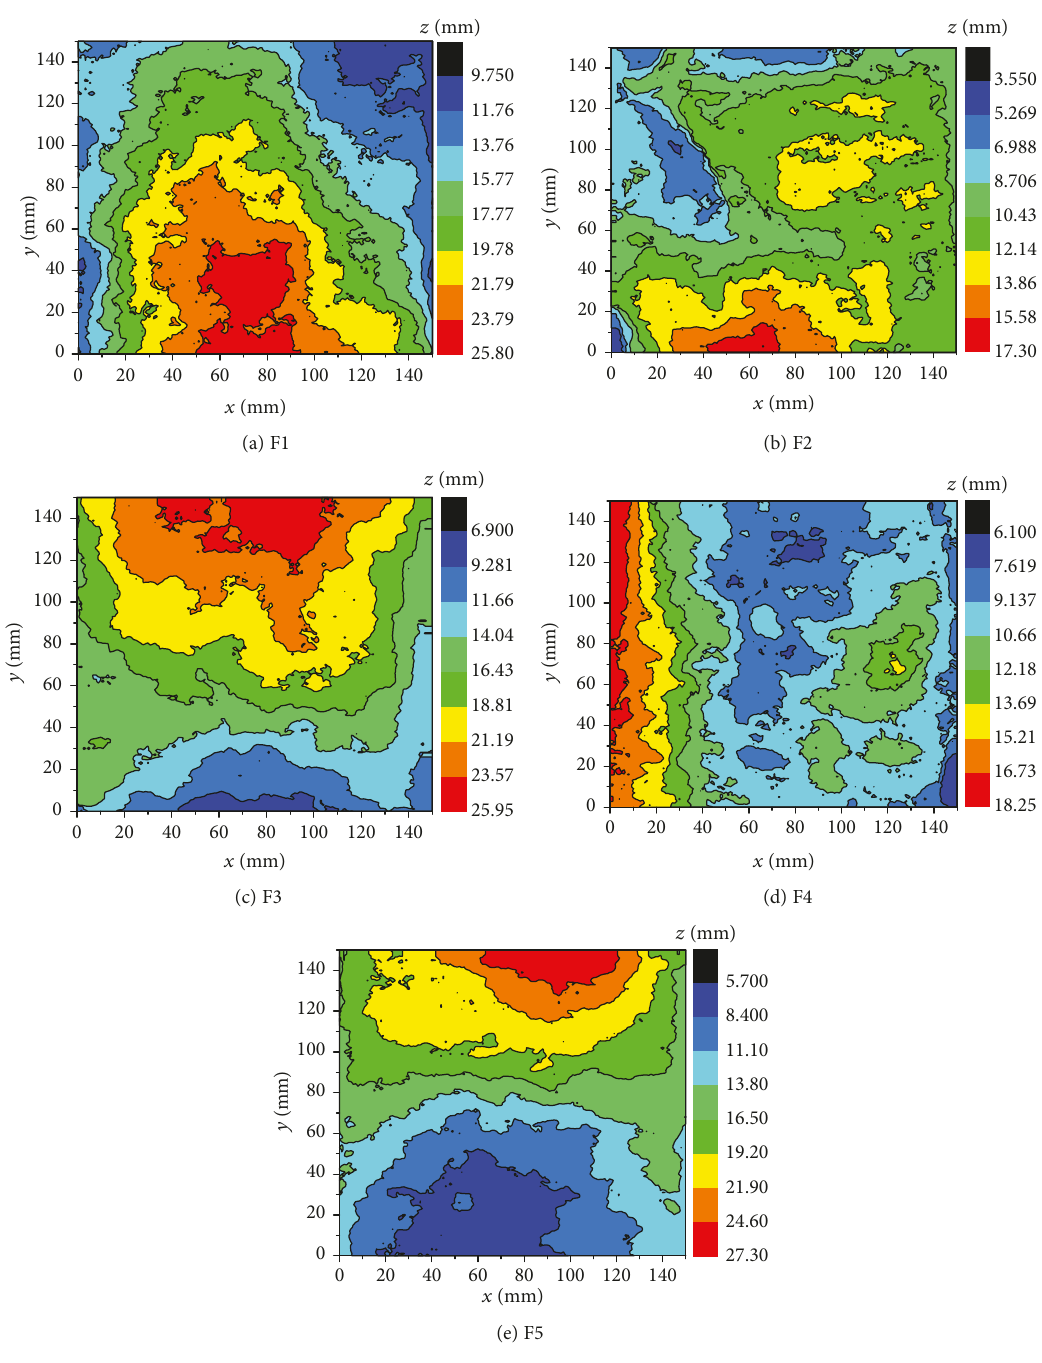
Figure 2: Surfaces topographies of fractures (lower surfaces). Table 1: Geometrical details of